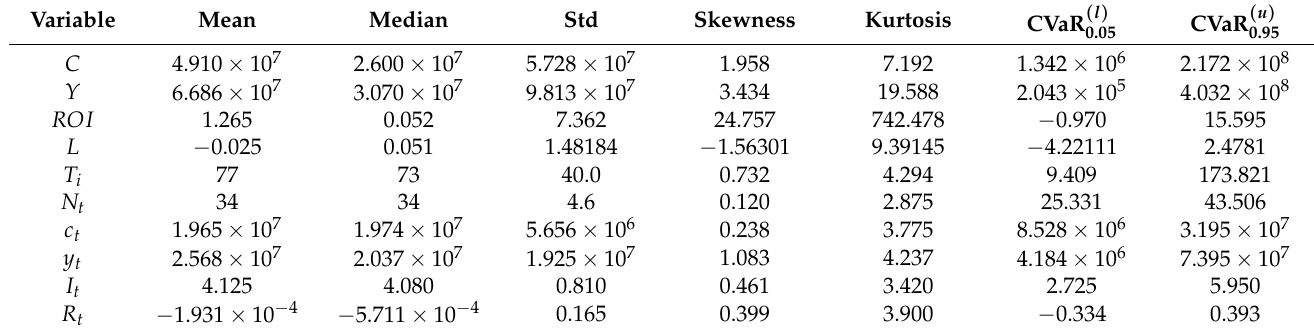
Table A1. Variables—Univariate Statistics.